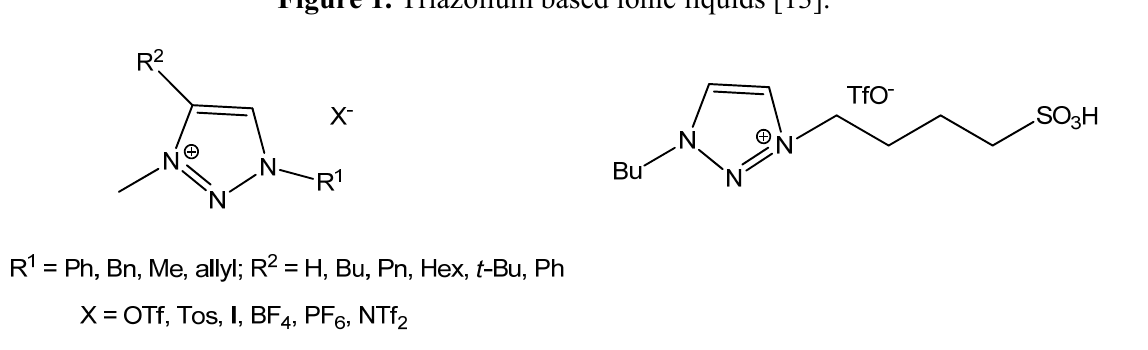
Figure 1. Triazolium based ionic liquids